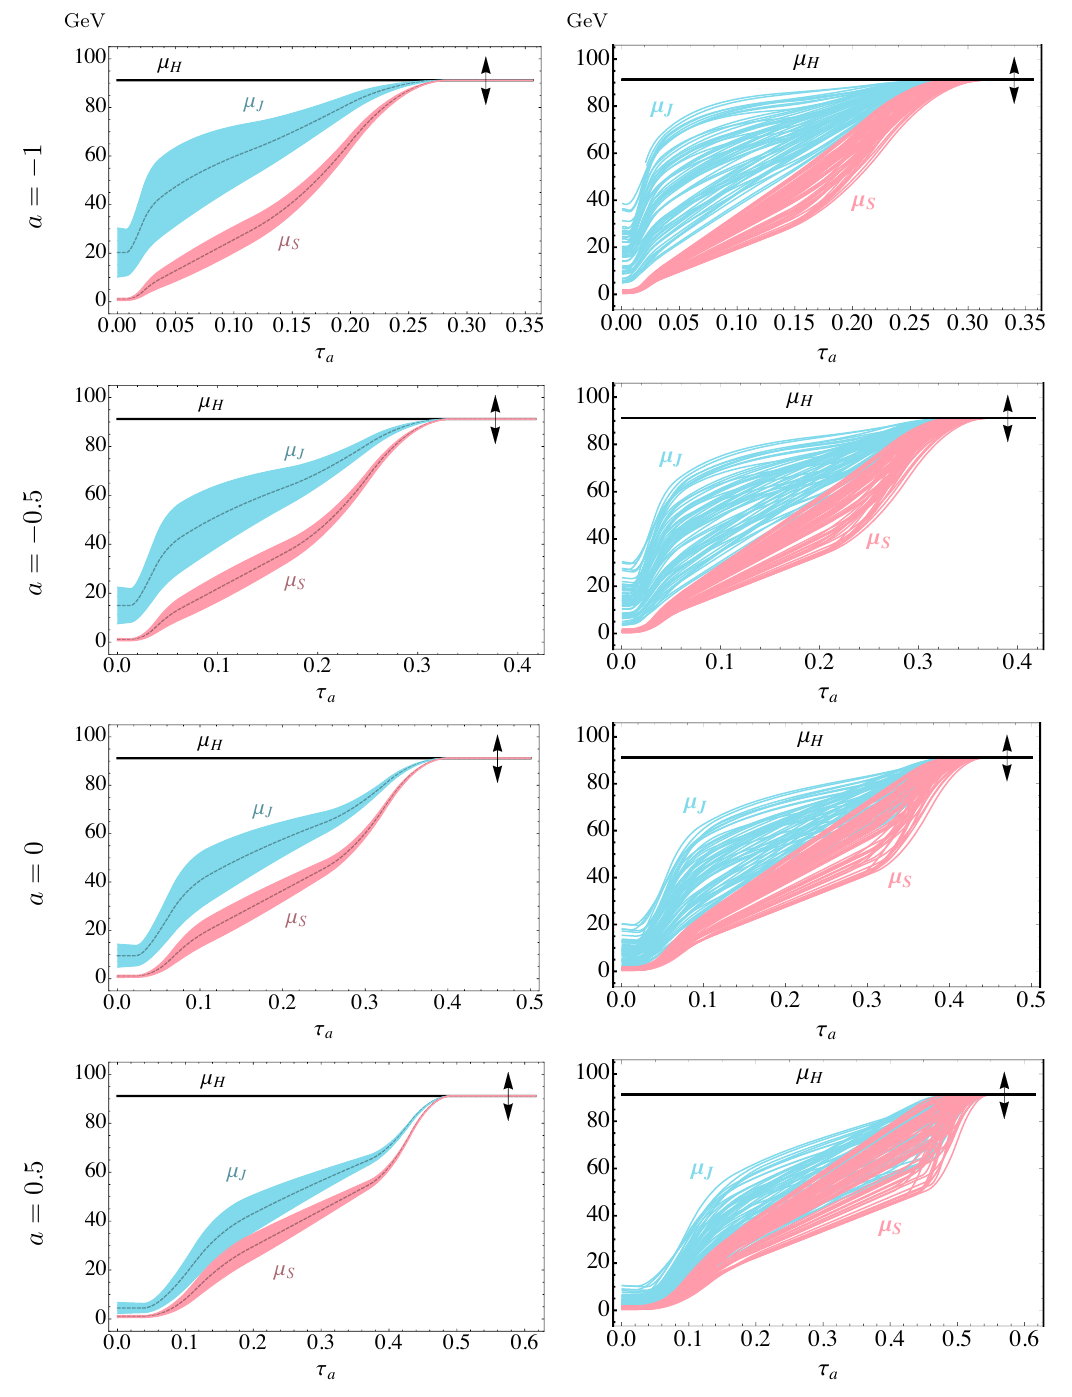
Figure 10 . Pro(cid:12)le functions implemented in our resummation, shown for a = and Q = m Z . Left : band method. Right : scan method. Each set of pro(cid:12)les (cid:22) H;J;S actually has a di(cid:11)erent absolute vertical scale set by (cid:22) H = e H Q , which has been rescaled for this illustration to e H = 1. Also, for each individual set of scales, it is the case that (cid:22) S < (cid:22) J , although the overall bands from the scan